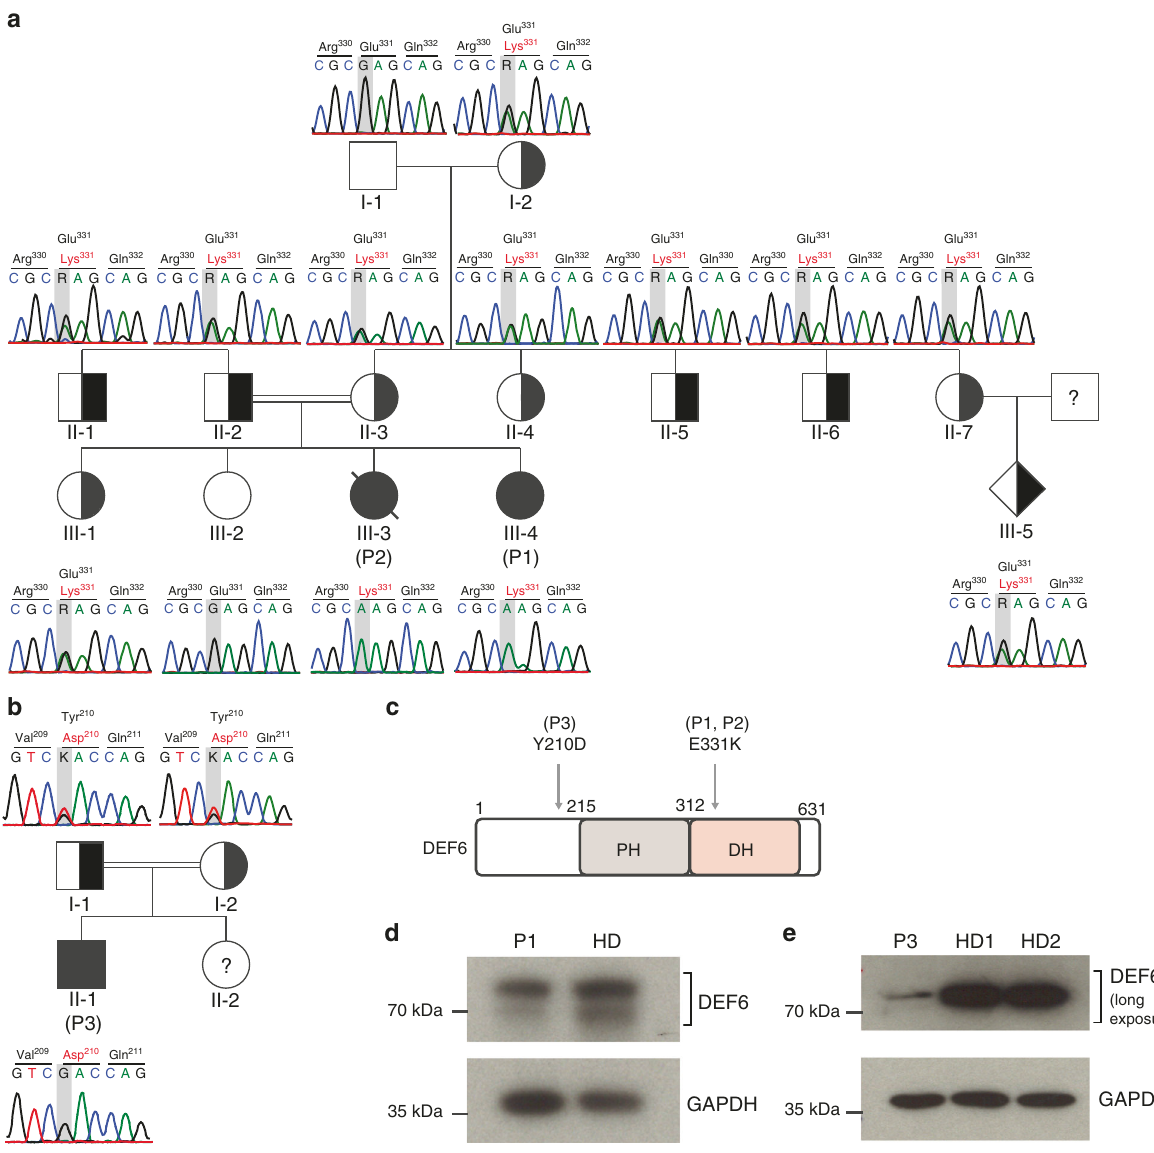
donor (Fig. S2e). Intriguingly, proliferation of PBMCs or feeder- expanded T cells was not compromised (Fig. S2f and g). DEF6 is also expressed, to a lesser extent, in NK cells (Fig. S2b). No defect in NK-cell immunological synapse formation could be detected (Fig. S2h). CTLA-4, similar to DEF6, is predominantly expressed in T cells. Given the marked response of P1 to Abatacept (CTLA-4- Ig) treatment enabling clinical disease remission (Fig. 1c – e), we hypothesized that autoimmunity in DEF6 de fi ciency may be linked to aberrant CTLA-4 regulation. Expression of CTLA-4 is predominantly regulated by FOXP3 (ref. 35 ) and calcium- dependent NFAT activation 36 . We fi rst analyzed CTLA-4